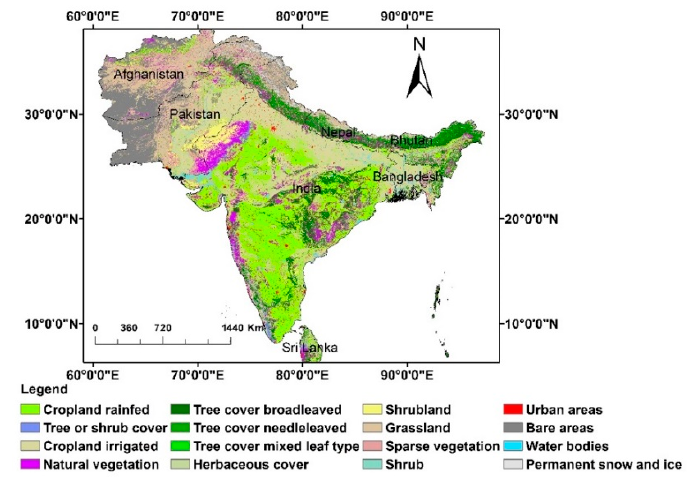
Figure 1. Land-use land cover map of South Asia based on ESA CCI-LC (European space agency climate change initiative-land cover) product.